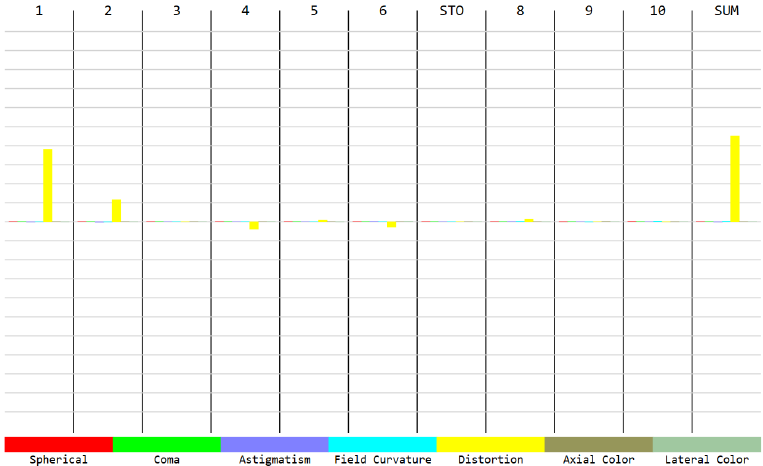
Figure 3. Five Seidel aberrations and (axial and lateral) chromatic aberrations. The main aberration is the barrel distortion, mainly induced by the first surface. This aberration is illustrated in more detail in Figure 4.